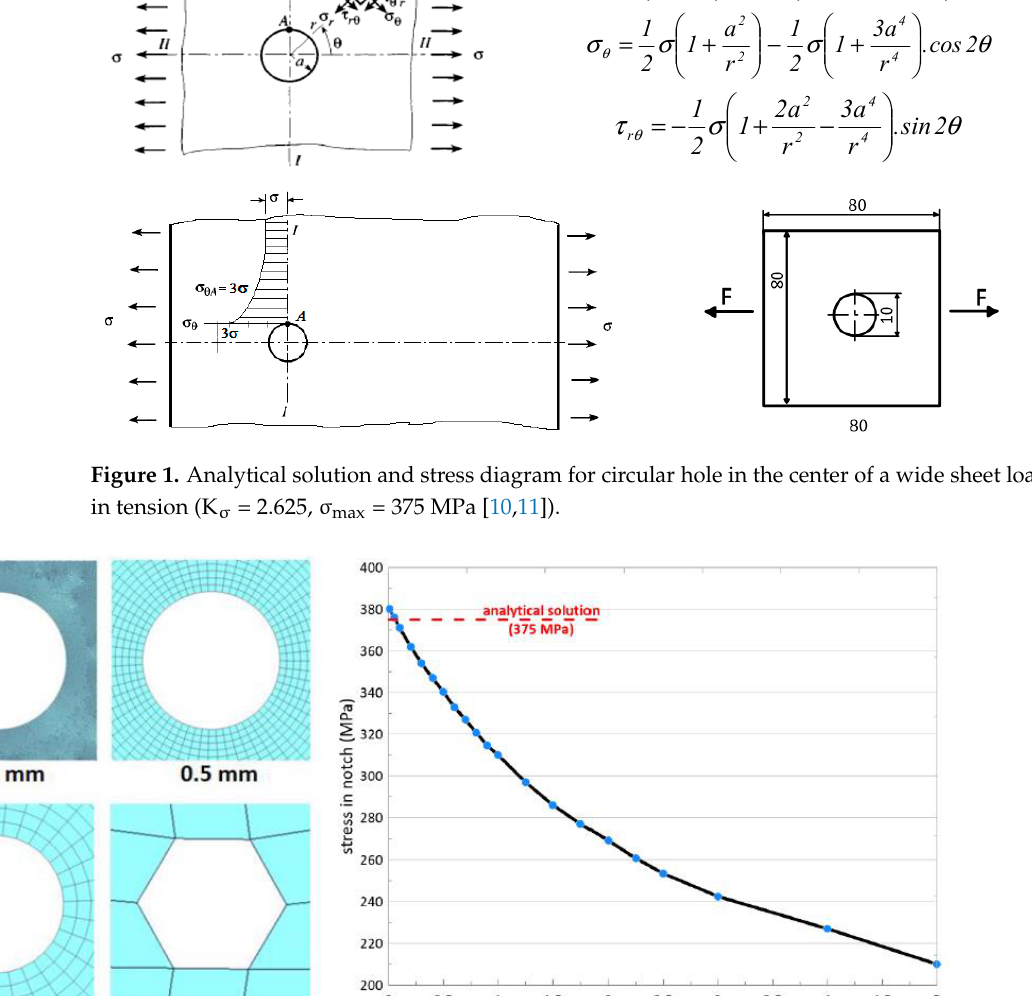
Figure 2. Mesh with an element sizes 0.1, 0.5, 1 and 5 (mm), and diagram of the peak stress in the root of the notch relative to element size diagram.